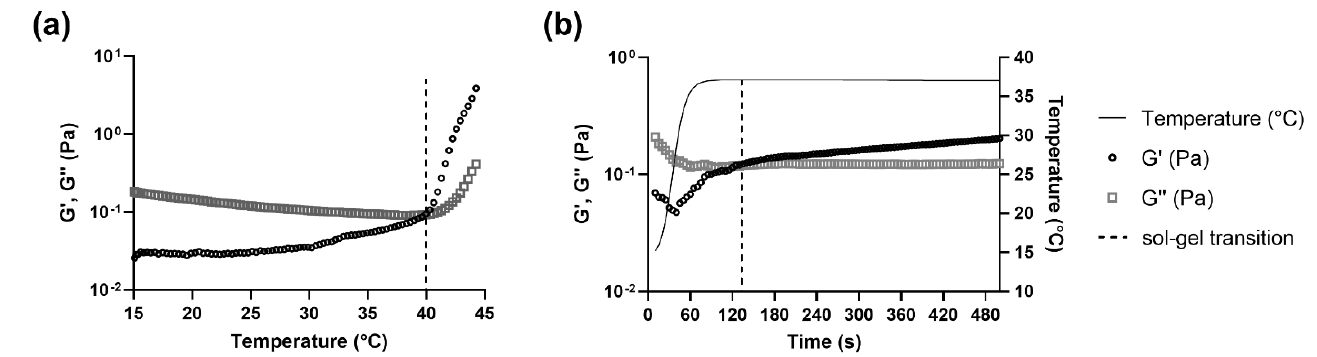
Figure 4. Representative rheological curves of temperature- and time-dependent sol-gel transition of sterilized chitosan with β -glycerophosphate (molar ratio 1:4.88) stored at − 20 °C. Measurement of the storage modulus (G ′ ) and loss modulus (G ″ ) during a ( a ) temperature sweep and ( b ) over time when simulating an injection (temperature rises from 15 to 37 °C in 75 s). The dotted lines represent the temperature and/or time at the sol-gel transition.